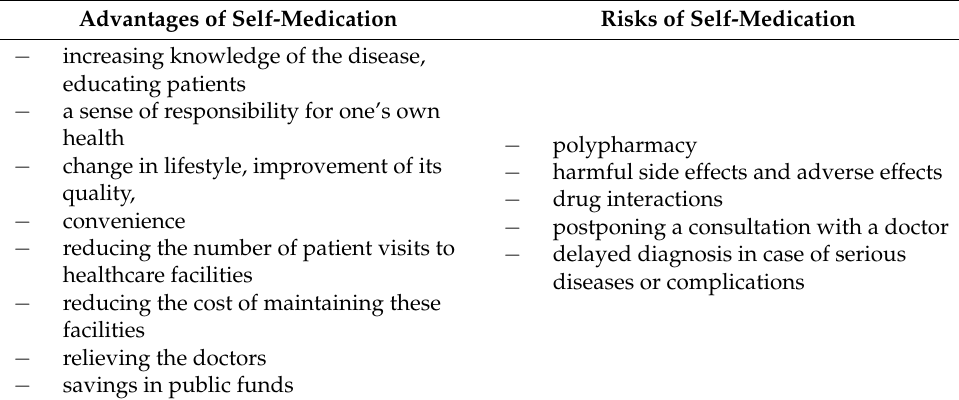
Table 2. Advantages and risks of